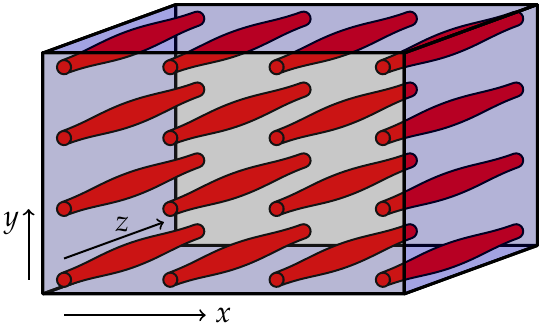
Figure 2. In our proposed experimental system, the wire medium will not be in free space but will be confined by metallic walls. Here we represent this in two ways, each containing a finite array of wires with varying radii. First, we confine the array in a rectangular waveguide with metal side-walls (in blue-gray), and use periodic boundary conditions to treat wires of infinite length. Second, we add metallic end-walls (grey) perpendicular to the wires to change the waveguide into a closed box or cavity . In either case we can do our numerical computations for only one period of variation in the wire radii. It is very important to note that this variation only corresponds to half a period of the electric